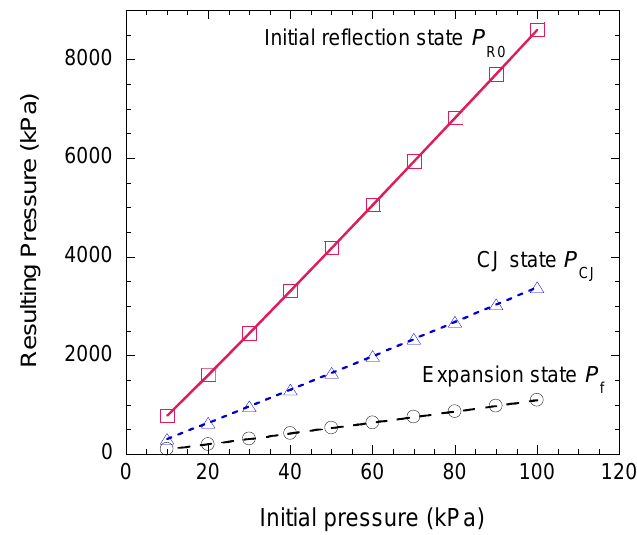
Figure 3. Incident Chapman–Jouguet (CJ) detonation pressure, reflected pressure and expansion pressure for stoichiometric C 2 H 2 / O 2 mixture at various initial pressures.